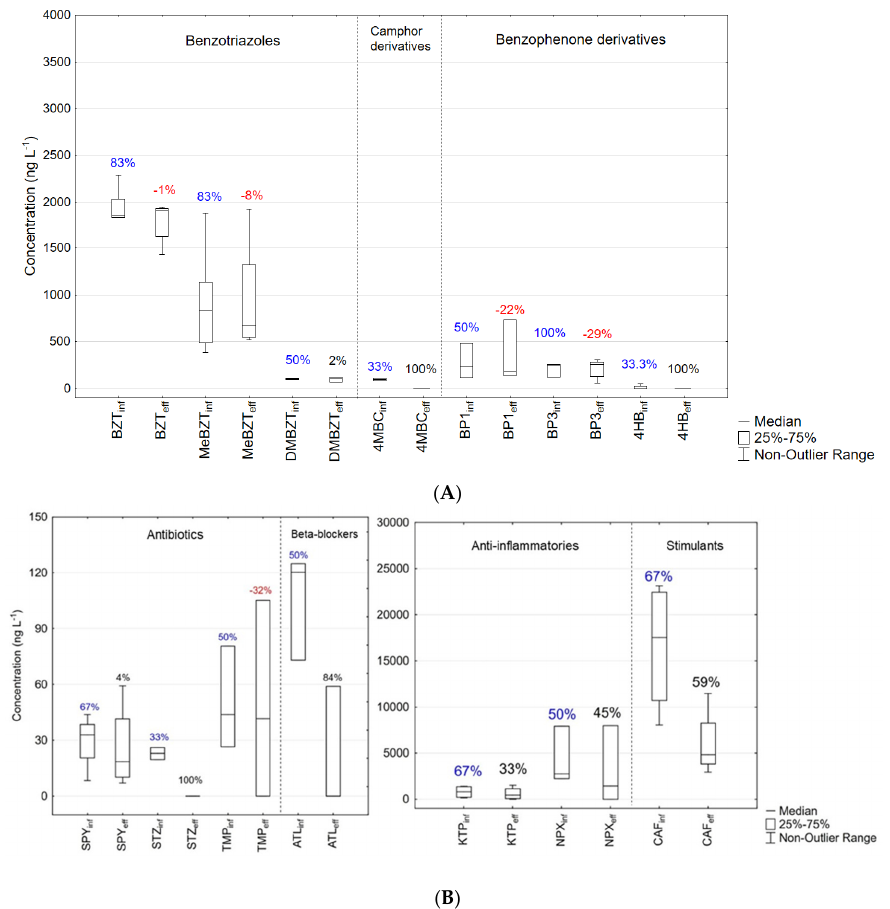
Figure 3. Concentrations of benzotriazoles and UV-filters ( A ) and pharmaceuticals ( B ) detected in the HRAP. For practical purposes, only compounds with frequencies of detection (F%) ≥ 33% (2 samples out of 6) are presented. The percentage value placed on top of the influent box plots refers to the frequency of detection in HRAP influent; the percentage value placed on top of the effluent boxplots corresponds to the average removal observed (RE%). Negative RE% values are depicted in red. For pharmaceuticals: SPY: sulfapyridine; STZ: sulfathiazole; TMP: trimethoprim, ATL: